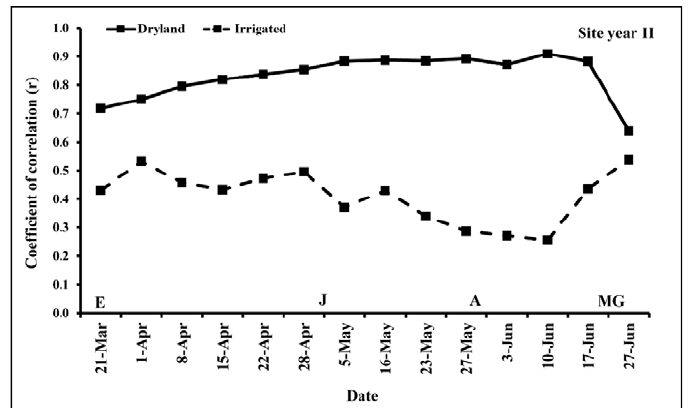
Figure 5. Correlation coefficient (r) between NDVI and grain yield across 24 winter wheat genotypes for site year II under dryland (solid line) and irrigated (dashed line) conditions across crop growth stages. Critical growth stages are indicated as A = anthesis growth stage, E = early spring growth stage, J = jointing growth stage, and MG = mid ‐ grain filling growth stage. Solid symbols show a significant correlation between NDVI and yield (p ‐ value < 0.05).